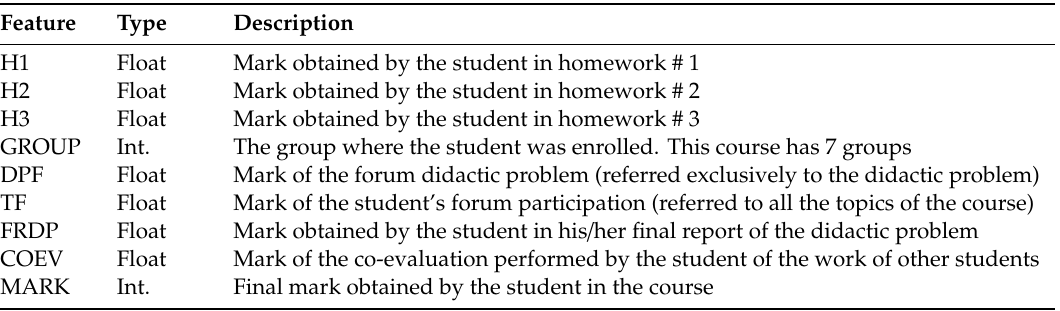
Table 6. Data features collected from the introductory course.